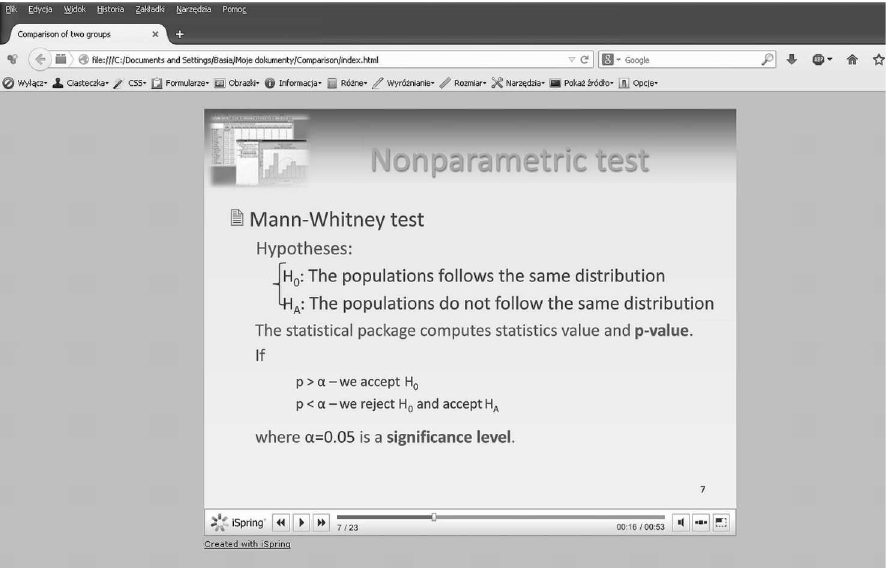
Figure 2. PowerPoint presentation saved as flash animation and viewed in the Mozilla Firefox browser – biostatistics material for medical students